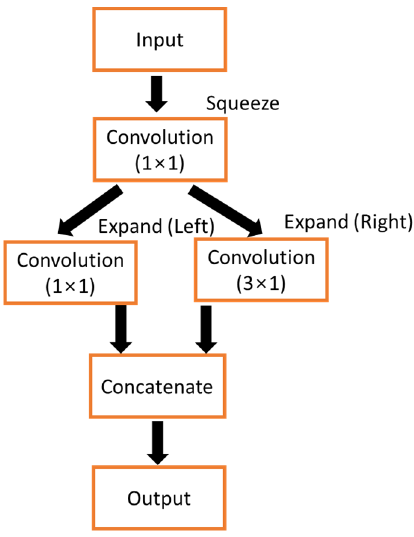
Figure 2. Structure of the proposed fire module of Squeeze U-net.